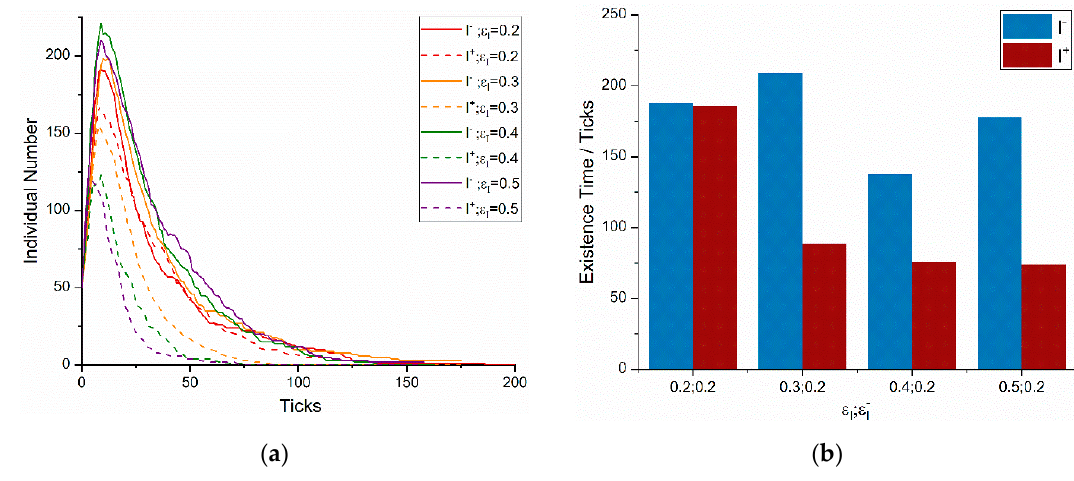
Figure 7. Brand OWOM communication effect when the brand advocators’ recessionary conditions are different. ( a ) The individual number of brand advocators and protesters; ( b ) the existence time of positive and negative OWOM.